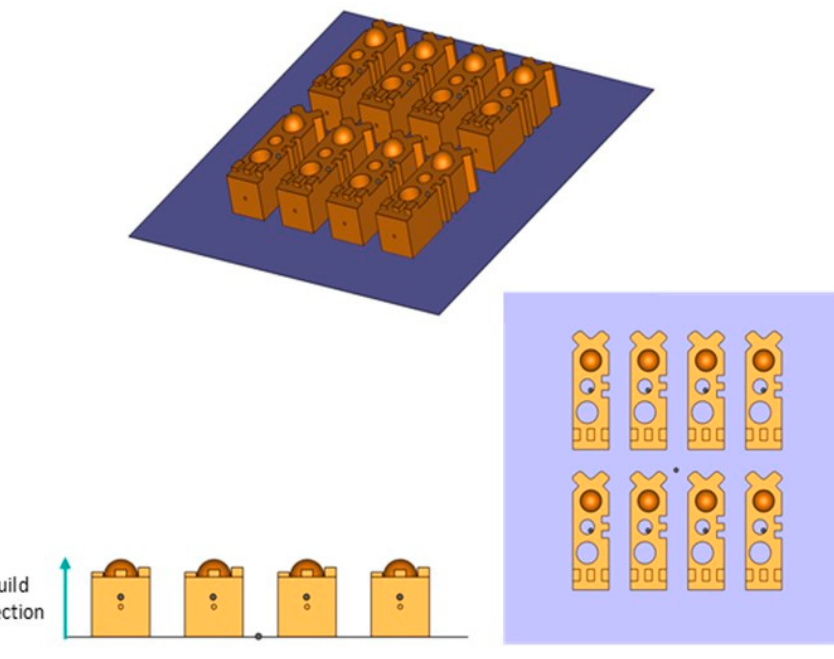
Figure 7. AM building strategy (showing eight parts).